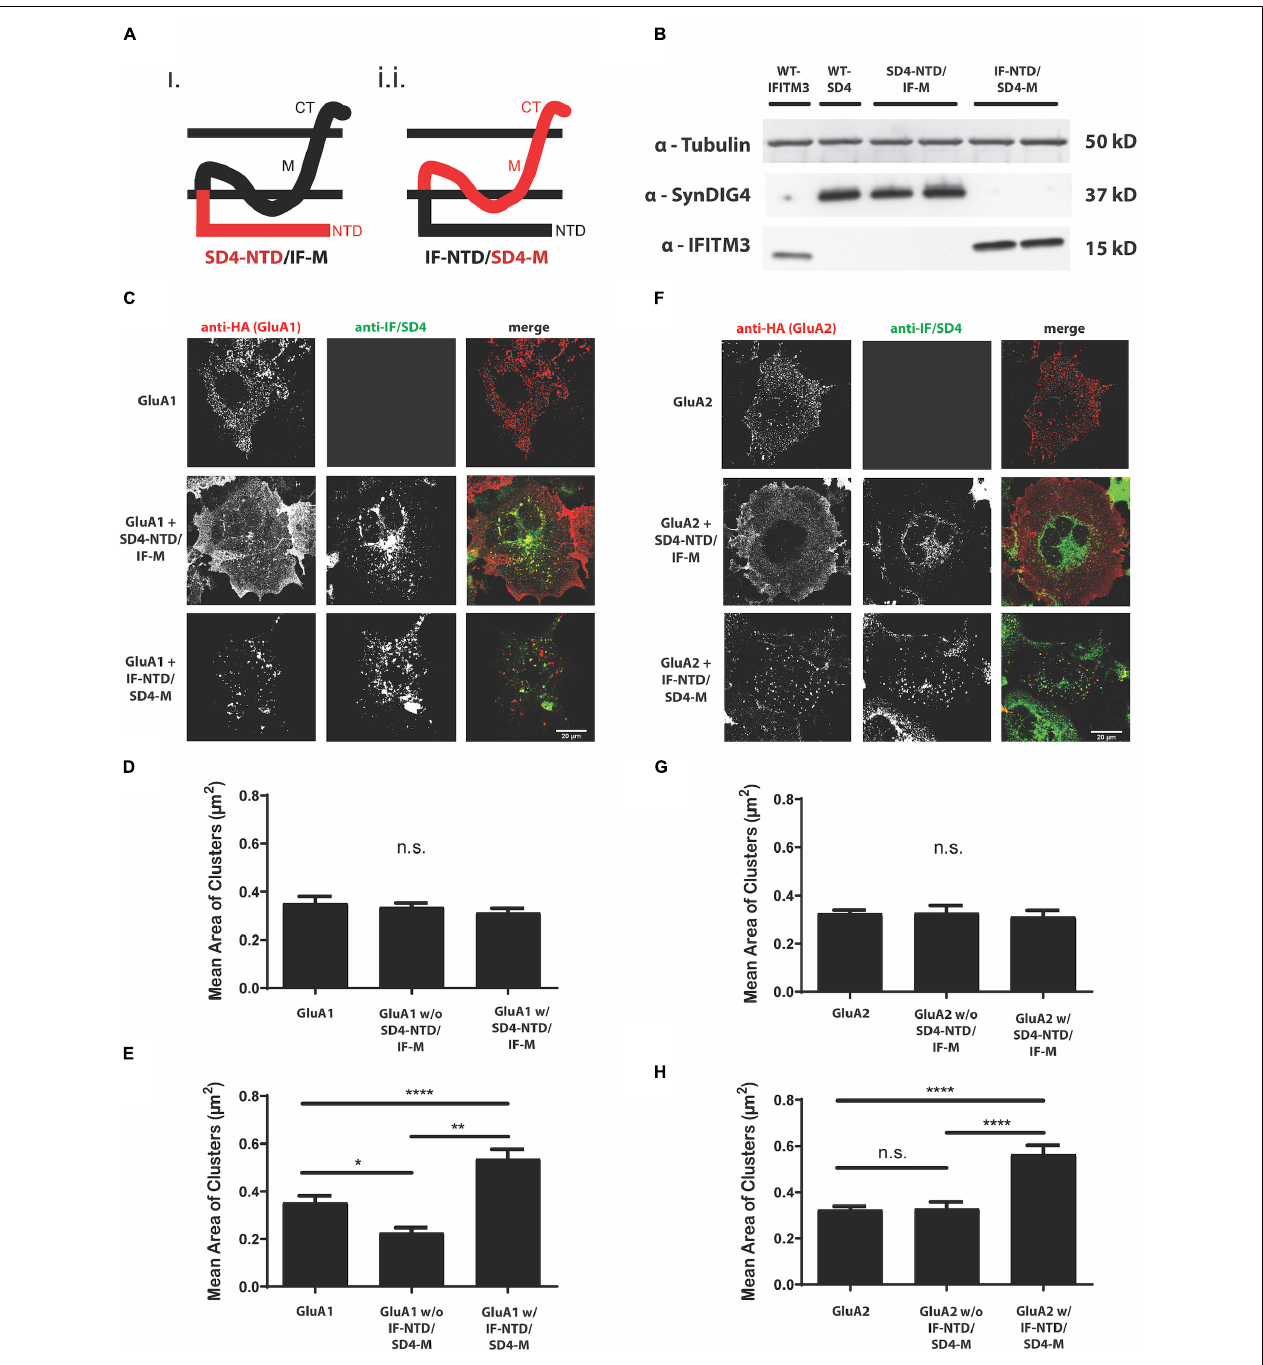
FIGURE 2 | The proline rich N-terminus of SD4 is dispensable for clustering with GluA1 and GluA2. (A) Schematic depicting the chimeric protein structures. Chimeras were generated expressing either (i) the N-terminus of SD4 and membrane domain of IFITM3 (SD4-NTD/IF-M) or (ii) the N-terminus of IFITM3 and membrane domain of SD4 (IF-NTD/SD4-M) (as shown in Table 1 of Methods). (B) Immunoblot of COS cell lysates transfected with SD4 and IFITM3 chimeras. β -tubulin was used as the loading control. (C) Representative confocal images depict either GluA1 expressed alone or co-expressed with either IF/SD4 chimera. Scale bar = 20 µ m. (D,E) Graph depicts the mean cluster size of GluA1 puncta from the stratification of GluA1 co-localized or not co-localized with SD4-NTD/IF-M chimeras (D) or IF-NTD/SD4-M chimeras (E) compared with GluA1 alone. GluA1 alone ( n = 10), GluA1 + SD4-NTD/IF-M ( n = 12), and GluA1 + IF-NTD/SD4-M ( n = 12). (F) Representative confocal images of GluA2 alone or co-expressed with IF/SD4 chimeras. Scale bar = 20 µ m. (G,H) Graph depicts the mean cluster size of GluA2 puncta from the stratification of GluA2 co-localized or not co-localized with SD4-NTD/IF-M chimeras (G) or IF-NTD/SD4-M chimeras (H) compared with GluA2 alone. GluA2 alone ( n = 13), GluA2 + SD4-NTD/IF-M ( n = 12), and GluA2 + IF-NTD/SD4-M ( n = 16). Data are represented as mean cluster size ± SEM; n.s. not significant; * p < 0.05; ** p < 0.01; **** p < 0.0001; one-way ANOVA with post-hoc Tukey’s test.